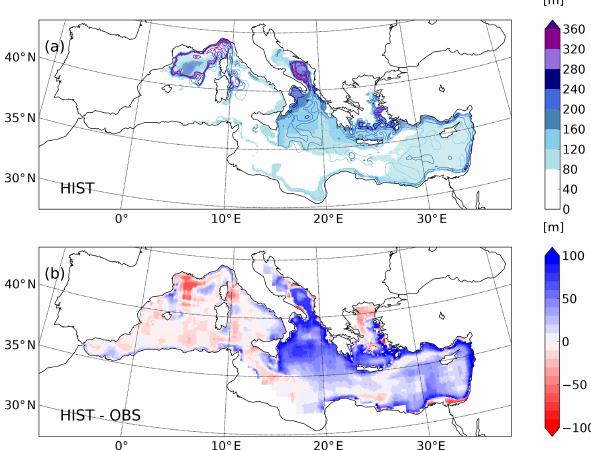
Figure 5. (a) Mixed-layer depth simulated in HIST (m) and as a deviation (b) of HIST from observations of Houpert et al. (2015) averaged over the entire simulation for JFM (January–February– March). Contour lines in panel (a) represent the maximum of MLD throughout the HIST